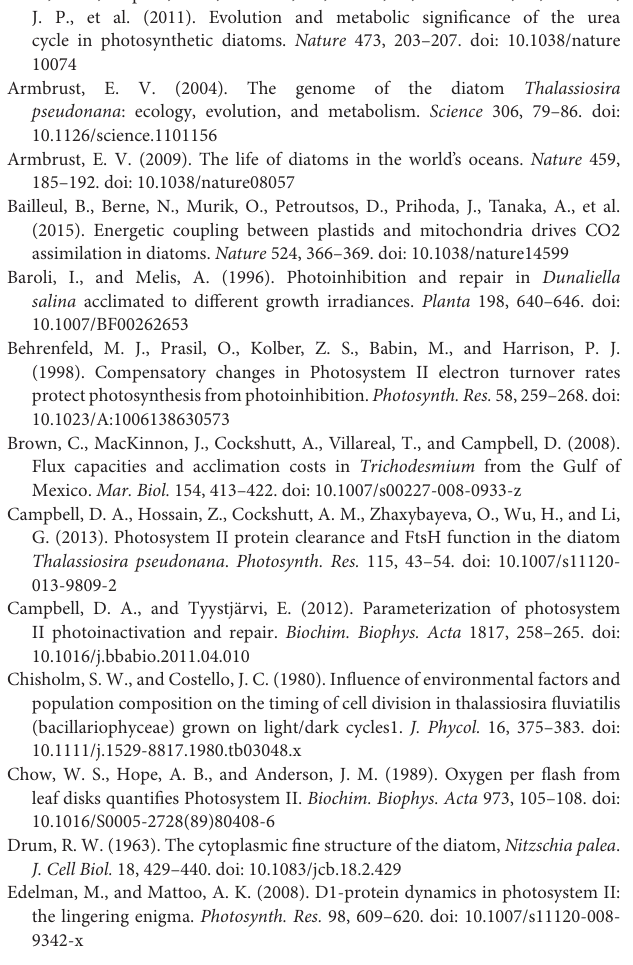
Supplemental Figure 6 | Comparison of paired determinations of fmol PSII activefluor µ g protein − 1 (A) or fmol PsbA µ g protein − 1 (B) from replicate cultures. Data from paired cultures of T. pseudonana (circles) and T. punctigera (triangles), growing under 75 (shaded symbols) or 300 (open symbols) µ mol photons m − 2 s − 1 . Samples taken from dark periods after either growth light are shown as closed symbols. Data is from cultures growing under 4:20, 8:16, or 16:8 L:D diel cycles. Paired T -tests show no significant difference between paired replicate data. Supplemental Figure 7 | Diel progressions of content of FtsH protease for T. pseudonana (A,C) or T. punctigera (B,D) vs. time of day for with a 16:8 L:D cycle indicated by horizontal bars along X axes. Points show repeated determinations upon two separate cultures for each